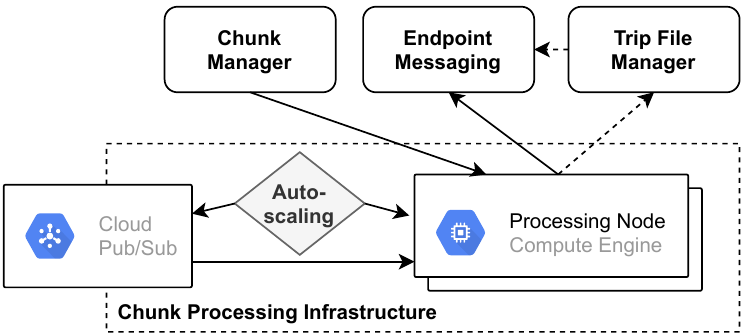
Figure 8. A message-based chunk processing infrastructure architecture: There is a pool of stateless processing nodes to handle the messages. Each message represents an executable job. We use this architecture to perform streaming or to generate trip